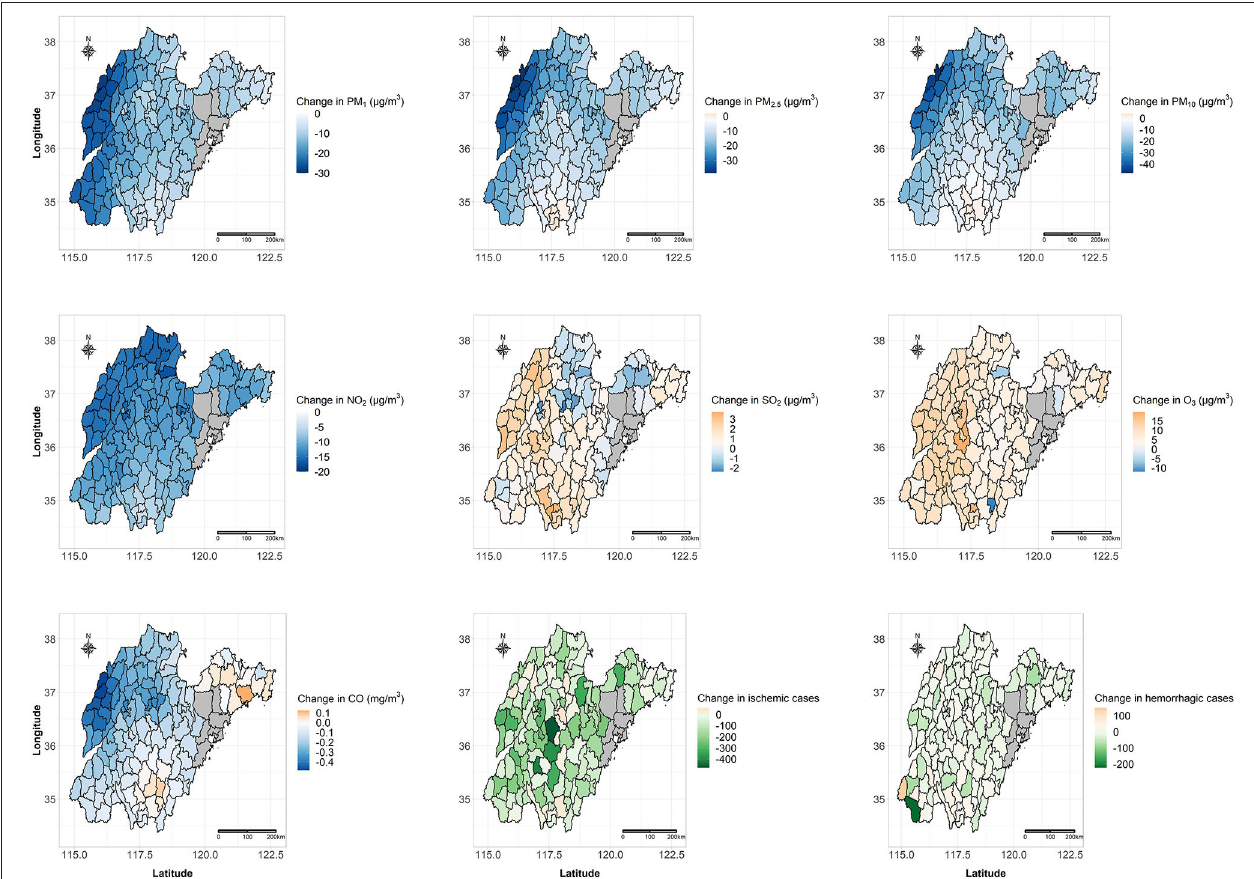
FIGURE 2 | Changes in population-weighted average air pollutant levels and stroke cases between the lockdown phase in 2020 and the counterfactual lockdown phase of the past 2 years for each of the 126 included counties using the DID model.